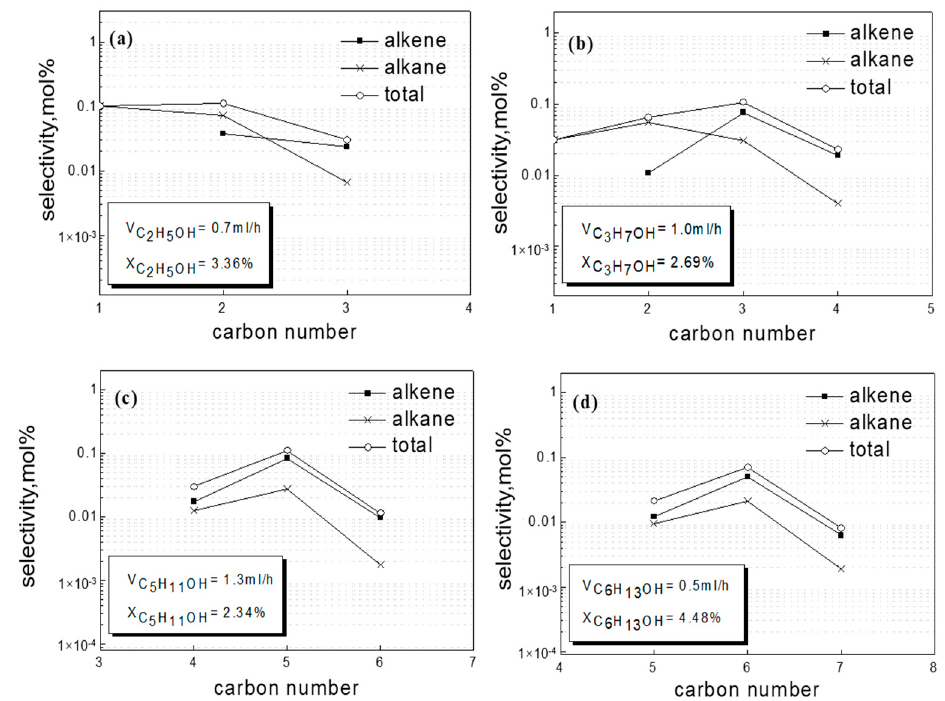
Figure 6. The dehydration of alcohols in an H 2 atmosphere over a reduced iron-based catalyst (T = 533 K, p = 0.8 Mpa). ( a ) C 2 H 5 OH addition. ( b ) C 3 H 7 OH addition. ( c ) C 5 H 11 OH addition. ( d ) C 6 H 13 OH addition.